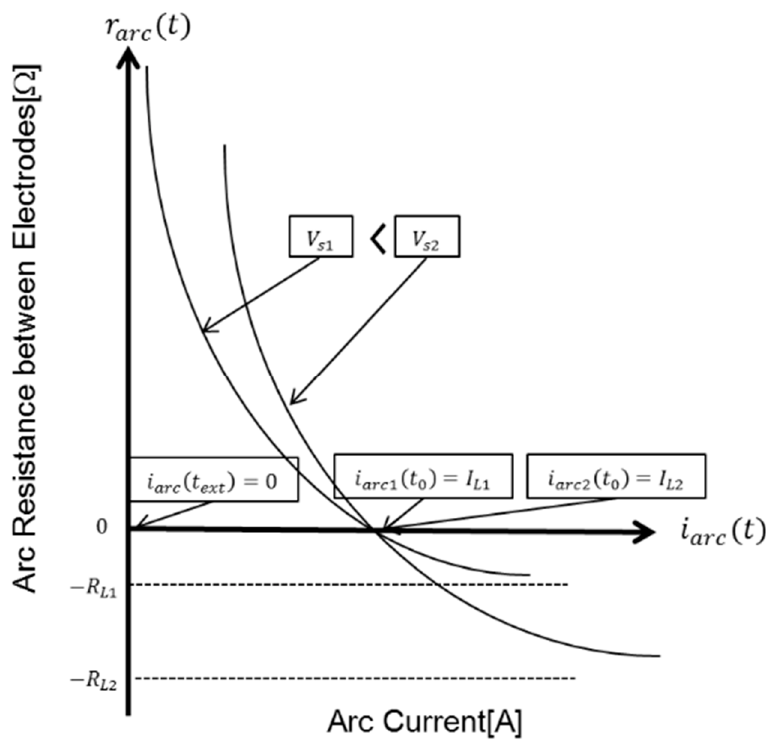
Figure 12. Relation between arc resistance and arc current with the parameter of source voltage change. Figure 13 is the experimental result graph of r arc and i arc according to the changes in source voltage.